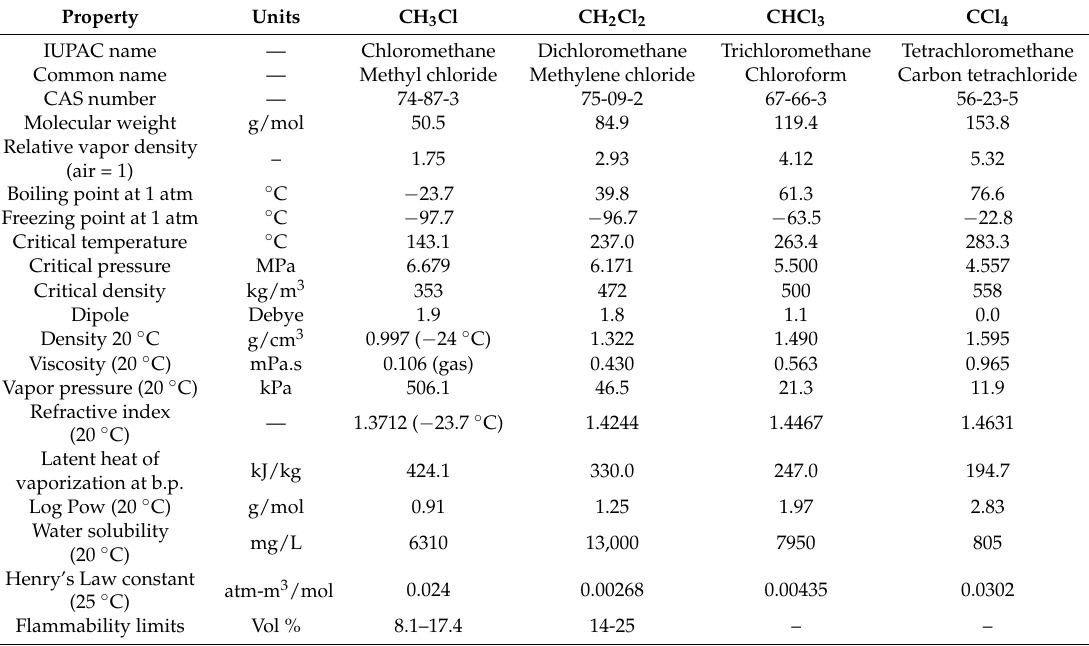
Table 1. Identification and physical properties of